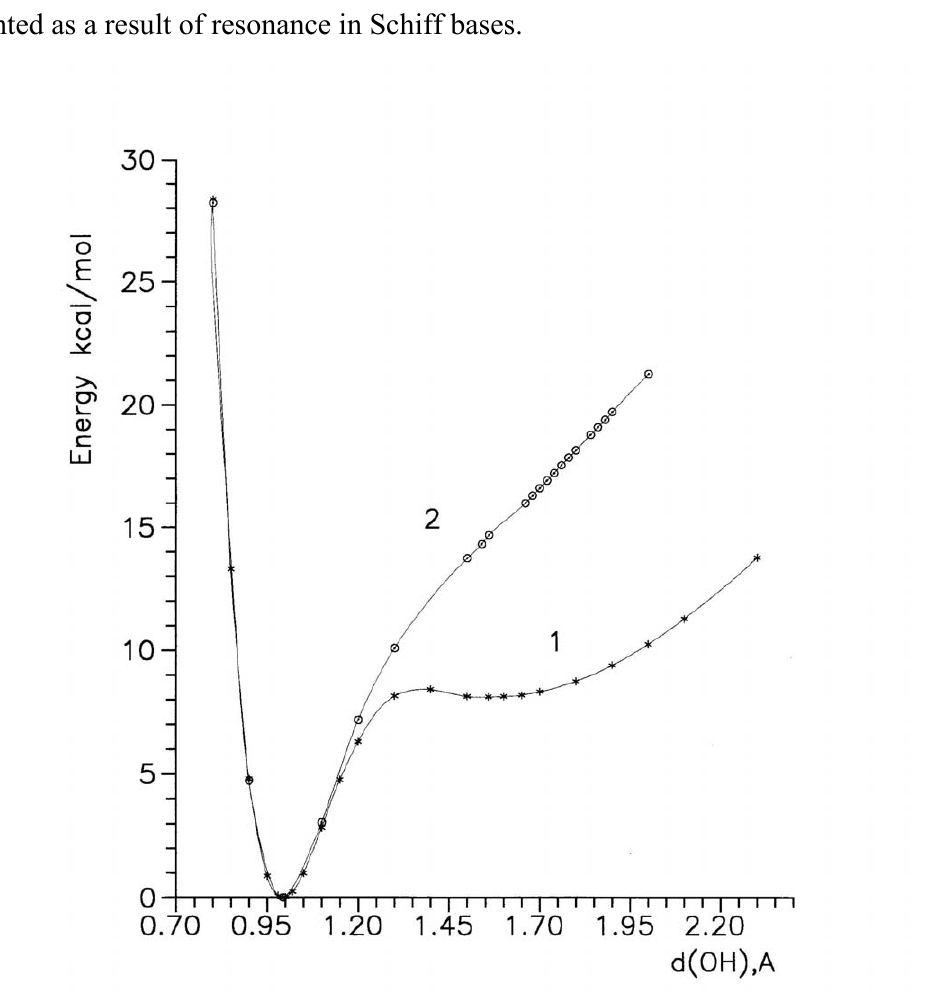
Figure 3. Potential energy (MP2/6-31+G(d,p)) dependence on O-H bond stretching in (1) Schiff and (2) Mannich